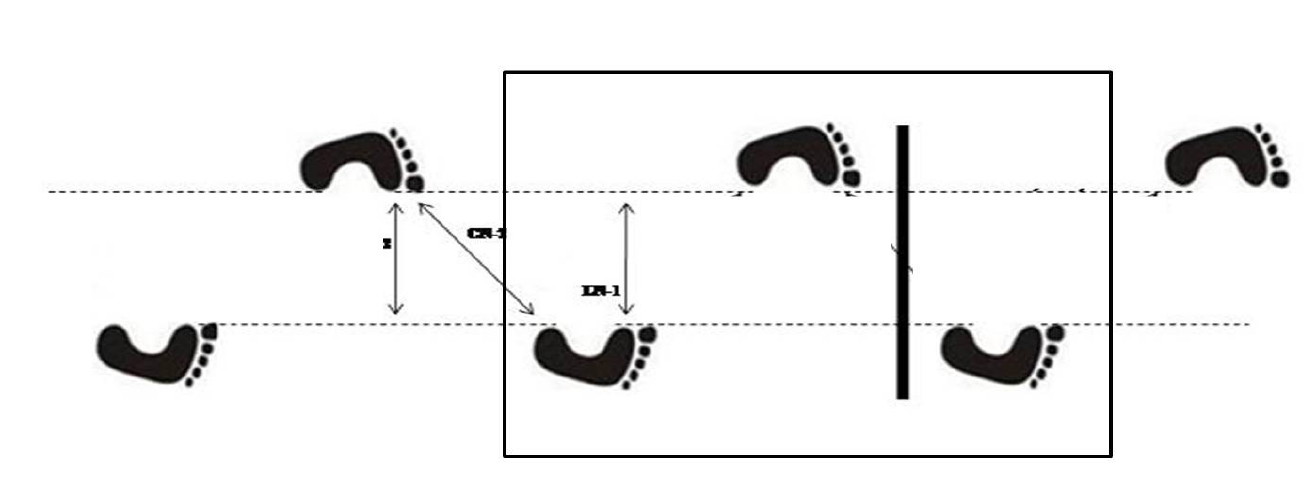
Figure 1. Top view of the stride